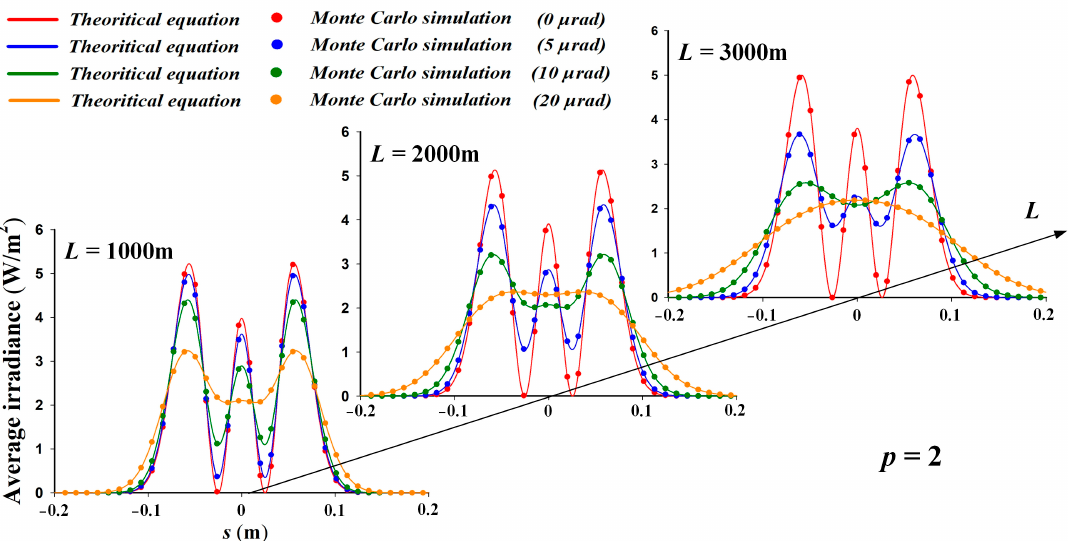
Figure 3. Average irradiance of HG beam under pointing error with the increase in propagation distance in the case of p = 2 .